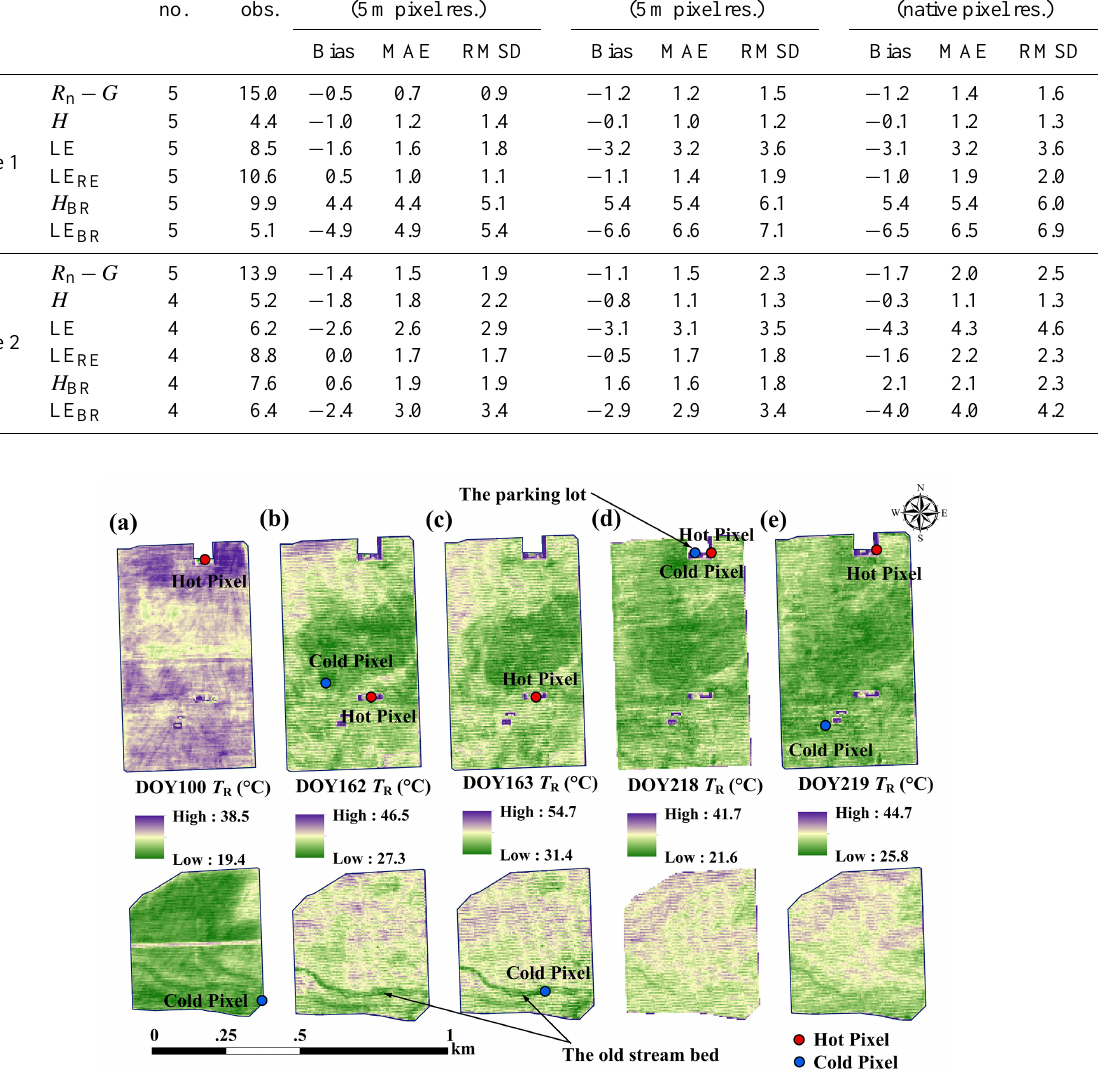
Figure 8. Locations of hot (red points) and cold (blue points) pixels selected from the T R maps for DATTUTDUT model on the 5 days.